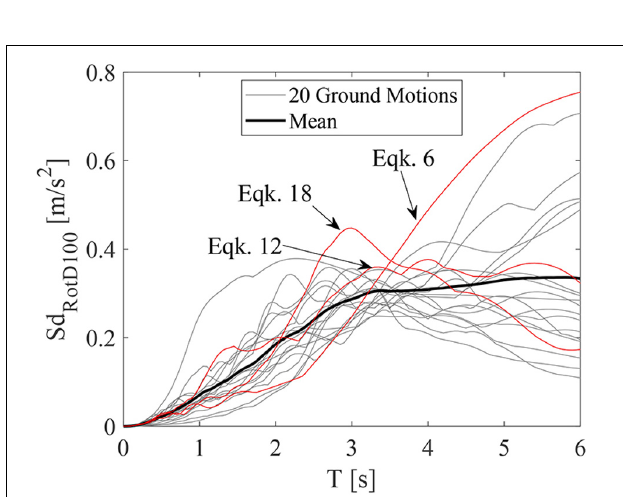
FIGURE 9 | Maximum inter-storey drifts (A) and maximum floor absolute acceleration (B) .